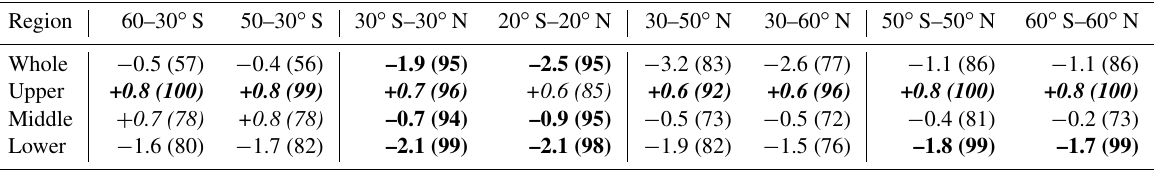
Table 1. Absolute change between 1998 and 2018 in Dobson units, and probability (in parentheses) of a positive or negative change in ozone (%) for integrated regions of the stratosphere. Standard text indicates that ozone changes are negative, italic text indicates positive changes, and bold text indicates probabilities exceeding